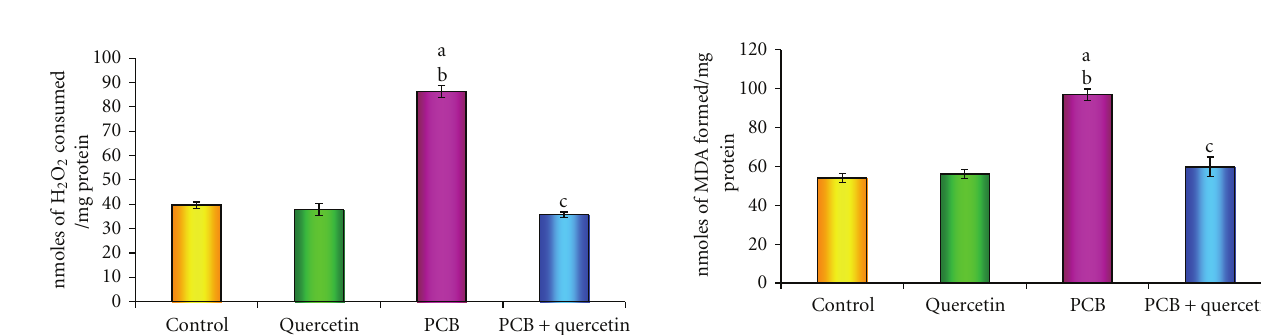
Figure 2: E ff ect of quercetin on H 2 O 2 generation in hippocampus of PCBs-exposed adult rats. Each bar represents mean ± SEM of 6 animals. Statistical significance is at P < 0 . 05 (a: Control versus others; b: Quercetin versus PCB, PCB + Quer; c: PCB versus PCB + Quer).